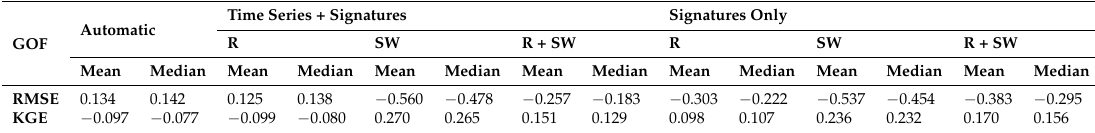
Table 2. Difference in RMSE (a) and KGE (b) for all groups of objective functions with respect to expert calibration. Automatic, time series + signatures and signatures only mean calibration strategies which combine runoff (R), soil moisture (SW) or runoff + soil moisture (R + SW).